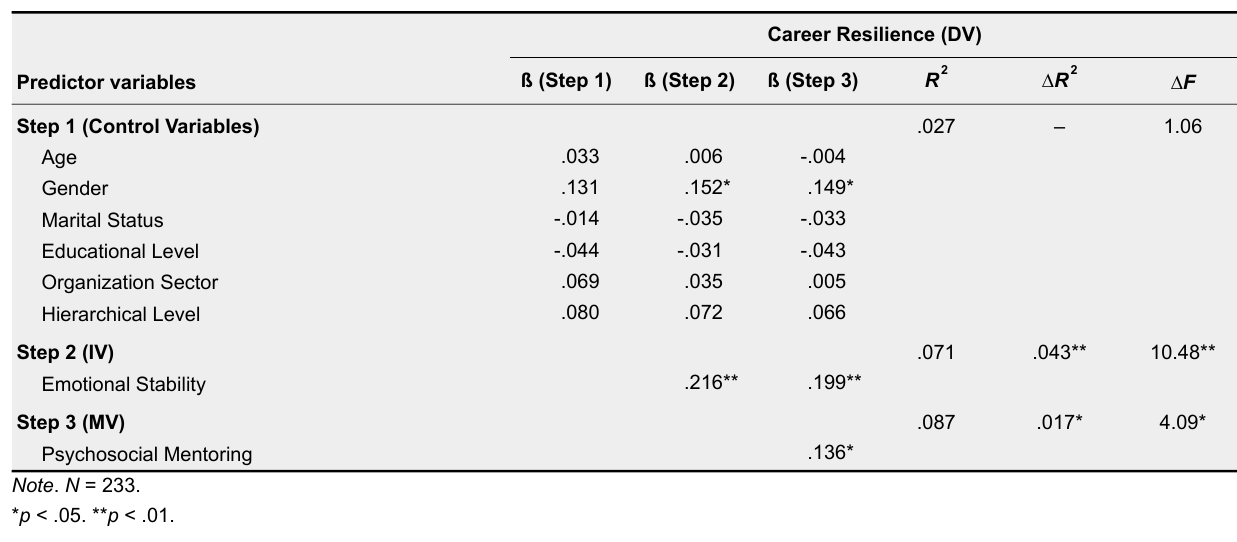
Hierarchical Multiple Regression Analysis: Mediating